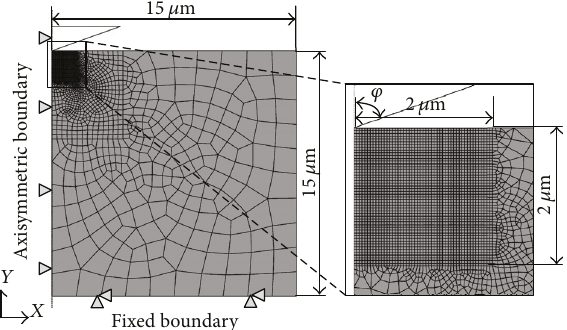
Figure 2: The two-dimensional meshed axisymmetric simulation model of nanoindentation. Table 2: Elastic and plastic properties of cortical bone. Yield Poisson’s, Young’s strength Material ratio, modulus, 𝜎 ] 𝐸 (GPa) 𝑠 (GPa) Cortical bone 13.56 0.3